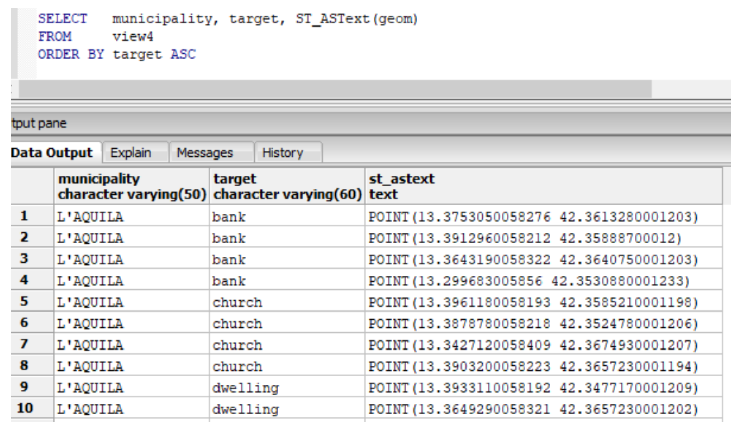
Figure 24. The damaged targets inside the municipality of L’Aquila and their geographical coordinates.